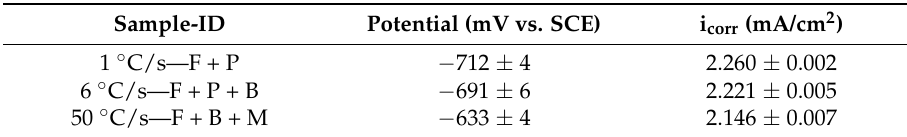
Figure 4. Tafel extrapolation diagram of electrochemical corrosion measurements of different quenching rate on low carbon steel samples. E corr : Corrosion potential, i corr : Corrosion current rate. Table 1. Electrochemical quantitative data on different quenching rate of DS and TS steels in 3.5 wt. % NaCl